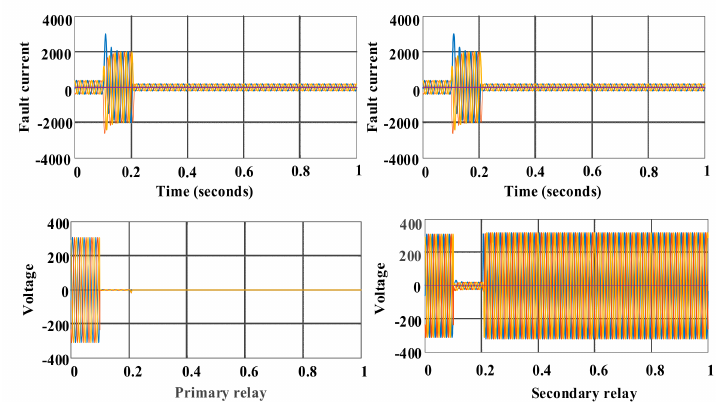
Figure 2. Voltage and current waveform of the primary/backup pair of the relay for the single-end radial